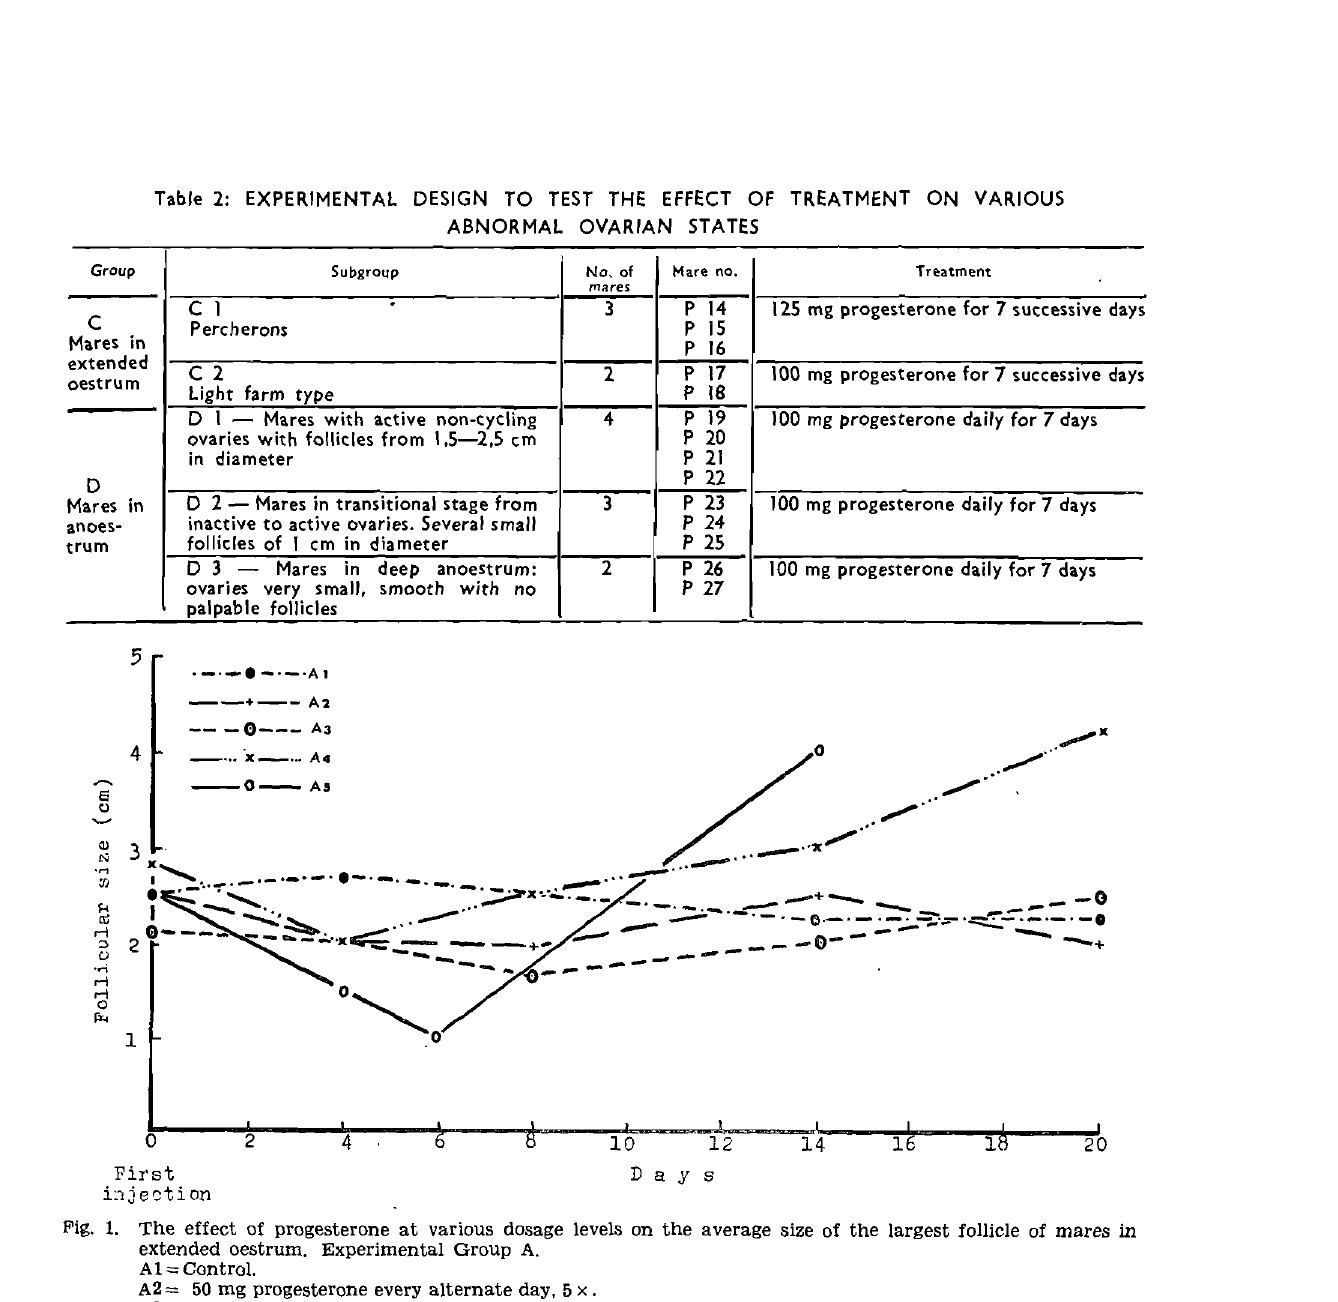
Fig. 1. The effect of progesterone at various dosage levels on the average size of the largest follicle of mares in extended oestrum. Experimental Group A. A1 '= Control. A2= 50 mg progesterone every alternate day, 5 x. A3 == 75 mg progesterone every alternate day, 5 x . A4= 100 mg progesterone every alternate day, 5 x. A5 == 100 mg progesterone every day, 7 x . 75 mg of progesterone respectively (Group A2 7 days, showed a decrease in follicular size and AJ), showed little change in follicular during the treatment phase. The size of the size over the same period. Mares on alternate largest follicle 'increased rapidly during the day treatment with 100 mg progesterone post-treatment period to reach a size of 4,0 cm (group A,) showed a decrease in follicular 8 days after the last injection. size up to Day 4 after the initiation of treat The effecf·of. treatment on ovulation and ment, followed by a slow increase in follicular oestrum is seC out in figure 2. Mares in the size up to Day 14 and then a rapid increase control group", "'and those receiving 50 mg to Day 20 to reach the size of 4,25 cm. Group progesterone (groups Al and A 2) remained on A 5, receiving 100 mg progesterone daily for heat throughout the experimental 39